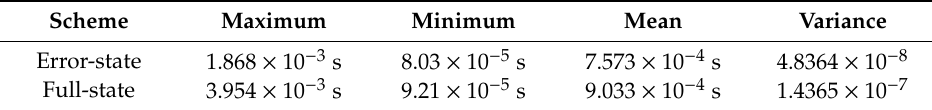
Figure 8. The filtering time of the error-state and full-state EKFs.